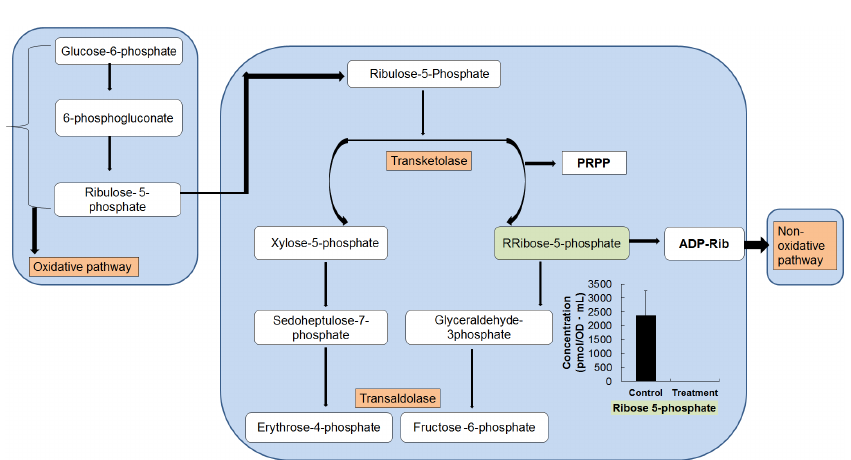
Fig 3. Metabolite changes observed in the pentose phosphate pathway (oxidative and non-oxidative pathway). Changesin the metabolitelevels of in the fermented O . japonicus by L . plantarum (gray bars) comparedwith those in the O . japonicus with L . plantarum (black bars) acquired by capillaryelectrophoresis time of flight mass spectrometry (CE-TOF-MS). The error bar indicatesthe mean standarddeviationof triplicate samples. The figure also includesa schematic diagramof the pentosephosphatepathway.